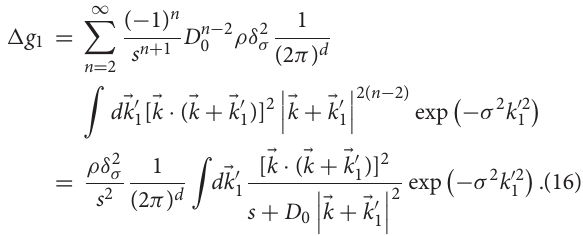
FIGURE 1 | Diagrammatic representation of the expansion terms diagrams in (A) represent the selection rules for (C) represent the set of irreducible diagrams 1 g 1 (Equation 16) that form the basis for the lowest-order correction due to